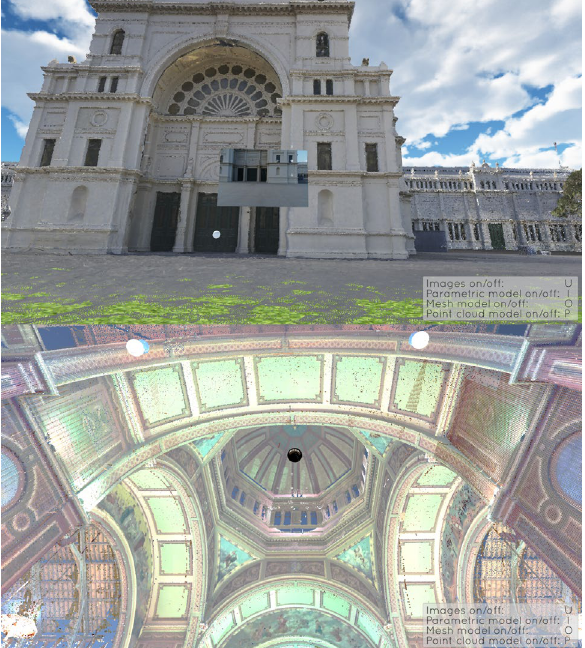
Figure 4. Images positioned in space based on where they were taken from. Plane with a photograph on top, sphere with a 360° panorama on the bottom.